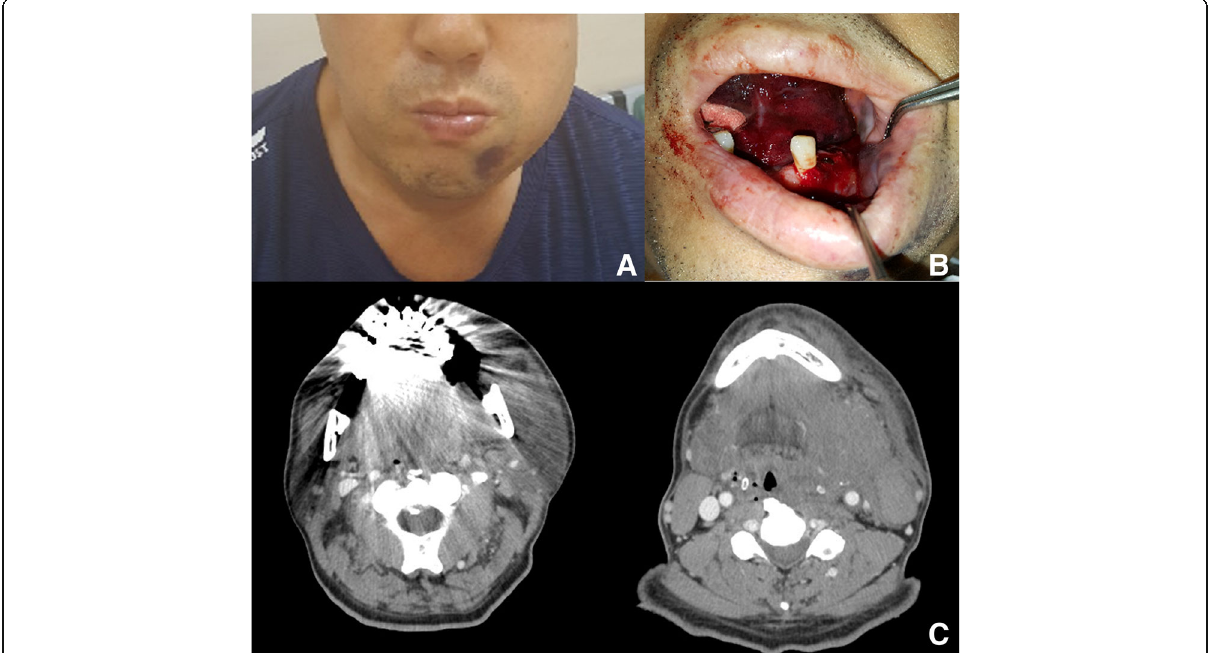
Fig. 1 a Facial swelling of an emergency room arrival. b Intra-oral view: mouth floor elevation and bleeding at the implantation site. c CT